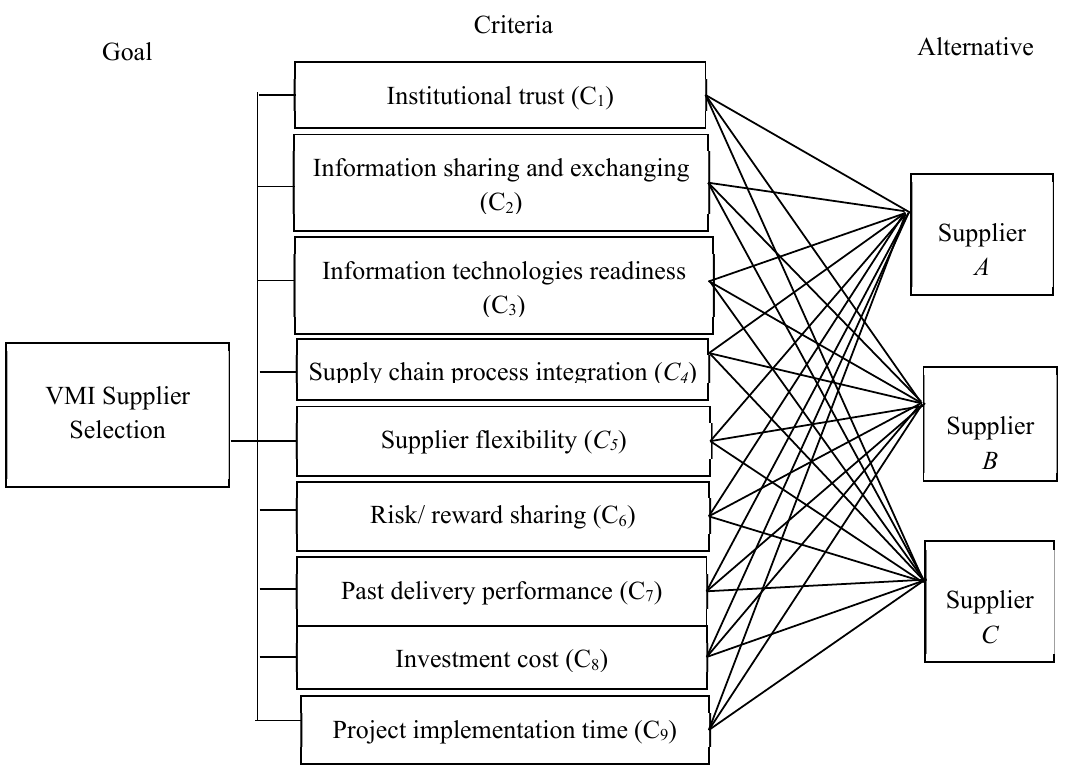
Fig. 4. The proposed model of VMI supplier